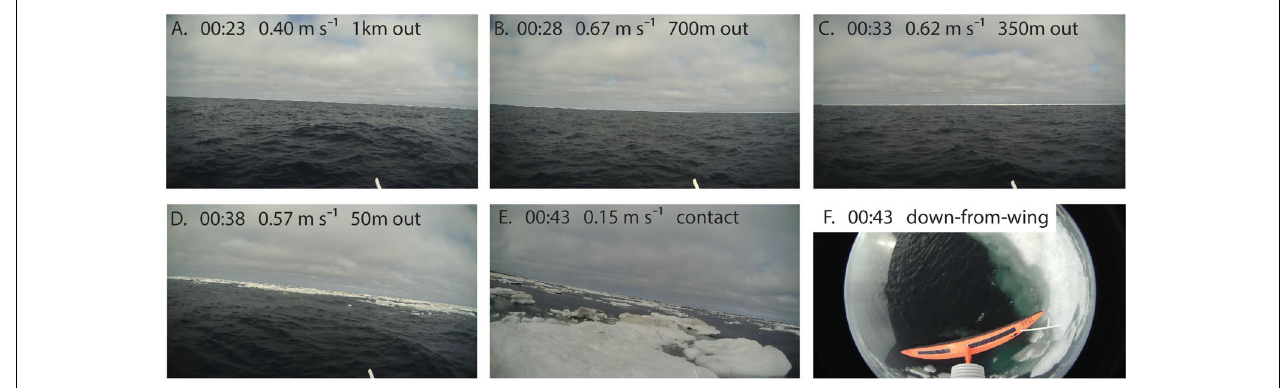
FIGURE 9 | Photos from the camera aboard sd-1036 as it approached the ice band targeted on 18 July 2019. Times in UTC. Distances listed are relative to the vehicle’s northernmost point of travel, at which point it was blocked by ice. Panels (A–E) are looking north, along the vehicle’s northward route. Photo (F) was taken looking down from the top of the vehicle’s